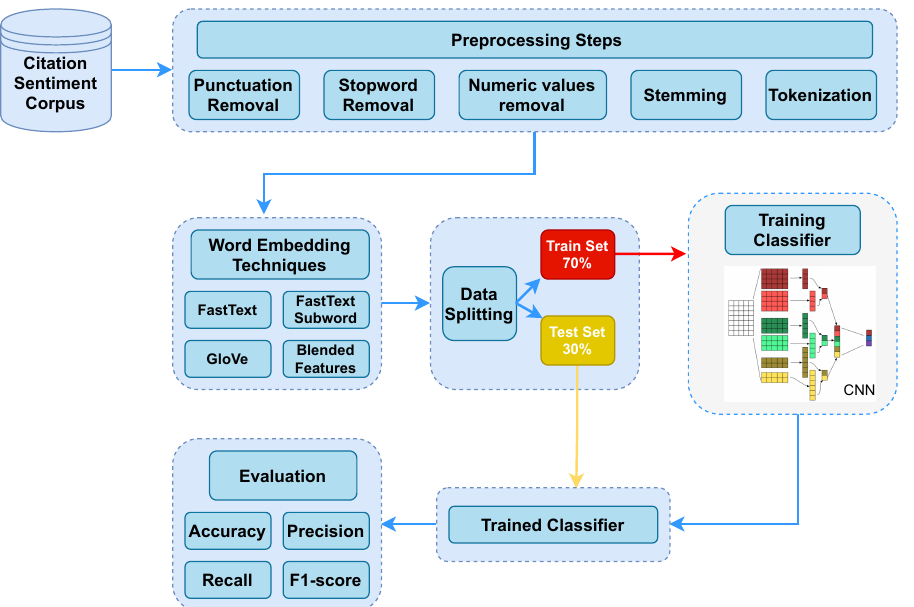
Figure 1. The architecture of the proposed methodology for in-text citation sentiment